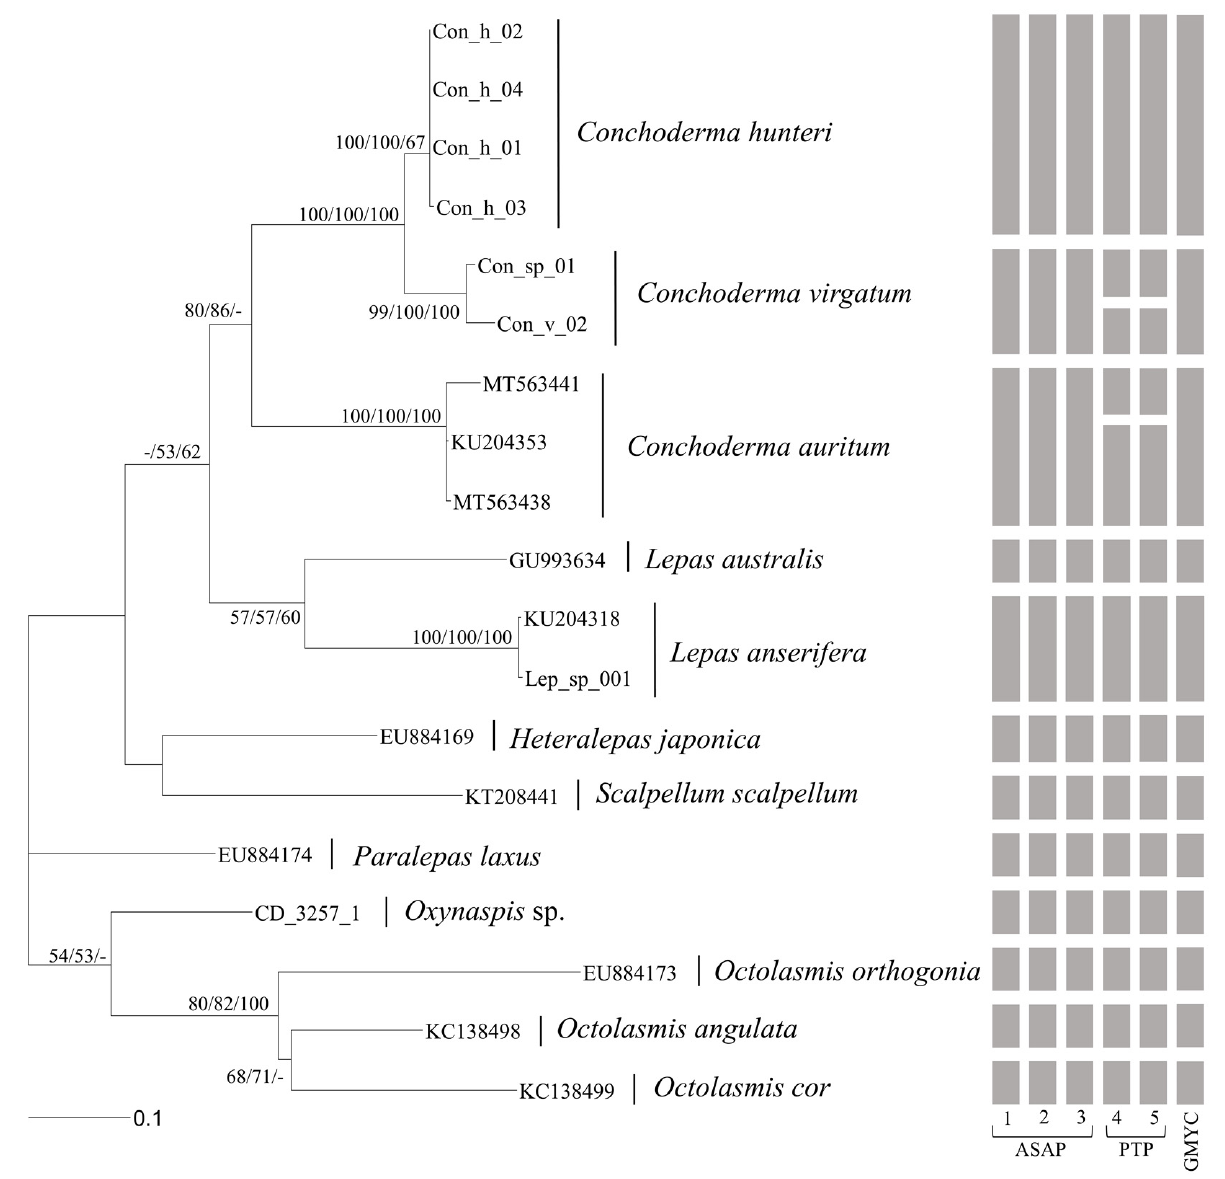
Figure 13. A Maximum likelihood (ML) phylogeny tree reconstructed with COI sequences by using MEGA11. Bootstrap values of neighbor joining (NJ), maximum likelihood (ML), and posterior probability of Bayesian inference (BI) are shown at the nodes when >50%, respectively. The species delimitation results of ASAP, PTP, and GMYC are indicated with vertical bars. The number of ASAP represent 3 models used for analysis, (1) Jukes-Cantor model (JC69), (2) Kimura 2-parameter model (K2P), and (3) Simple distance ( p -distances). The number of PTP analysis represent (4) Bayesian Poisson tree processes (bPTP) and (5) the PTP result of the Maximum likelihood solution. The K2P distances within C. hunteri and C. virgatum were 0.002 ± 0.001 and 0.034 ± 0.008 for the COI sequences, respectively. The K2P distances between C. hunteri and C. virgatum were 0.097 ± 0.016. The K2P distances between these two species and other species ranged from 0.242 to 0.354 (Table